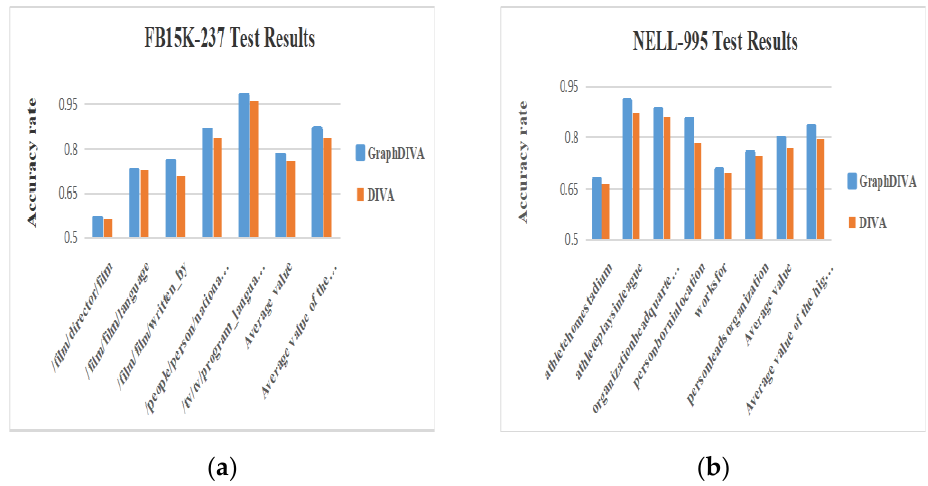
Figure 4. ( a ) Description of FB15K-237 test results; ( b ) description of NELL-995 test results.